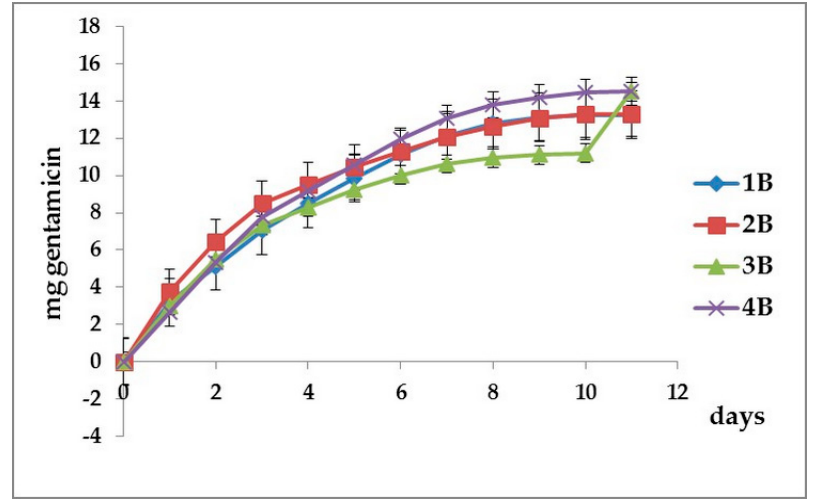
Figure 5. The cumulative amount of gentamicin released over time from samples 1B–4B.